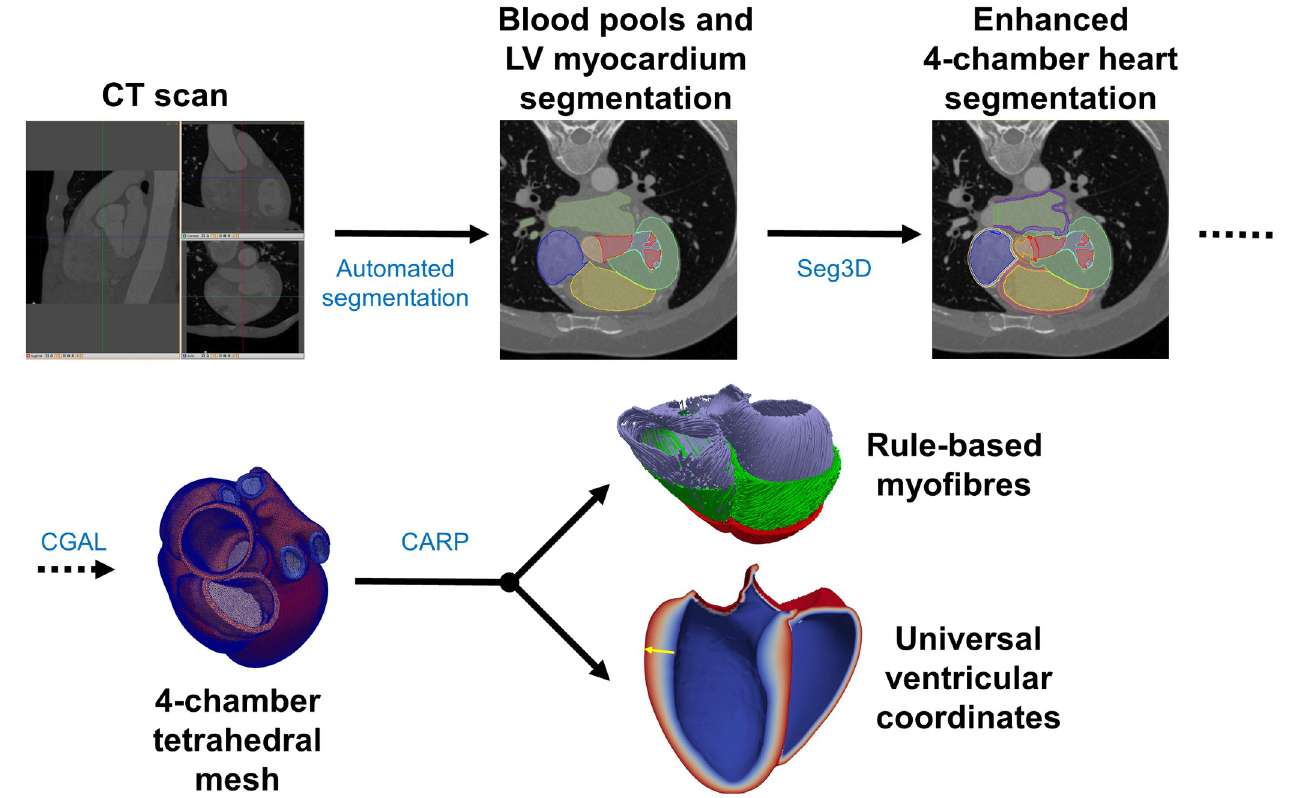
Fig 1. Schematic pipeline of the CT cohort creation, from CT scan to the final end-diastolic mesh including fibres UVC. More details on each one of the steps can be found in S1 and S2 Text.